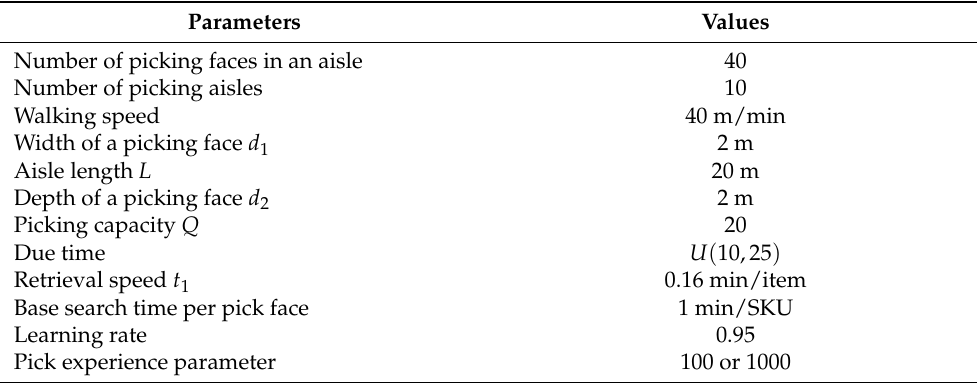
Table 3. Experiment